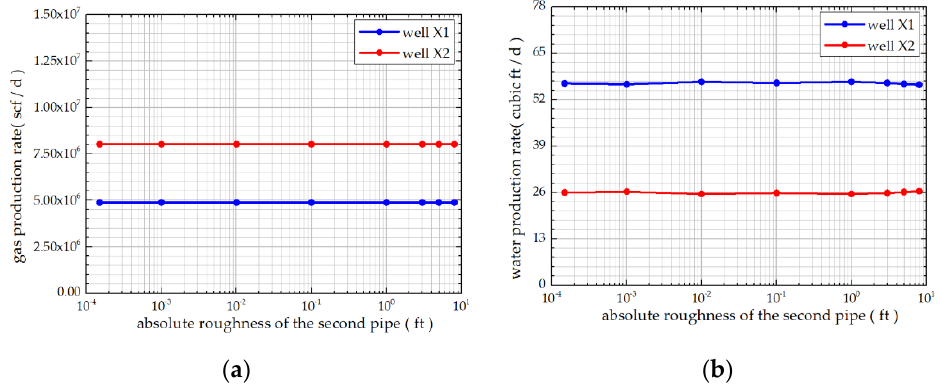
Figure 16. Calculation results under di ff erent absolute roughness of pipes: ( a ) gas production rate; ( b ) water production